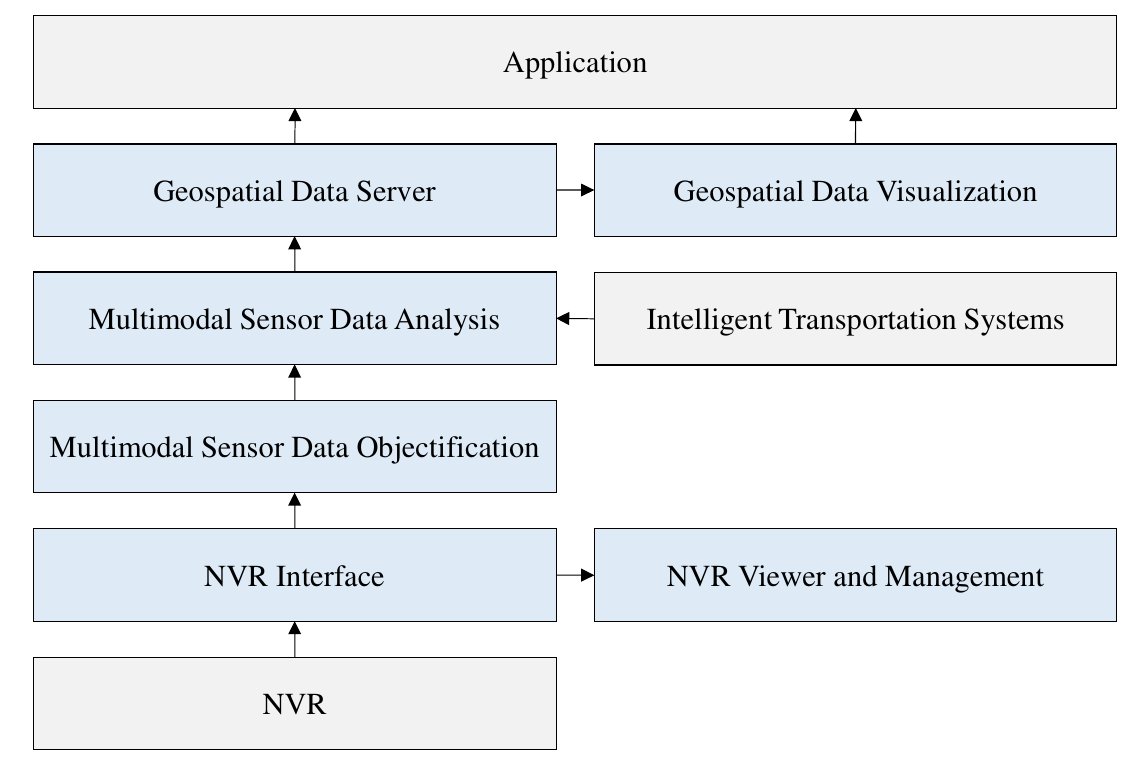
Figure 6. Structure of the proposed urban digital twin platform. The blue blocks are the modules proposed in our platform.